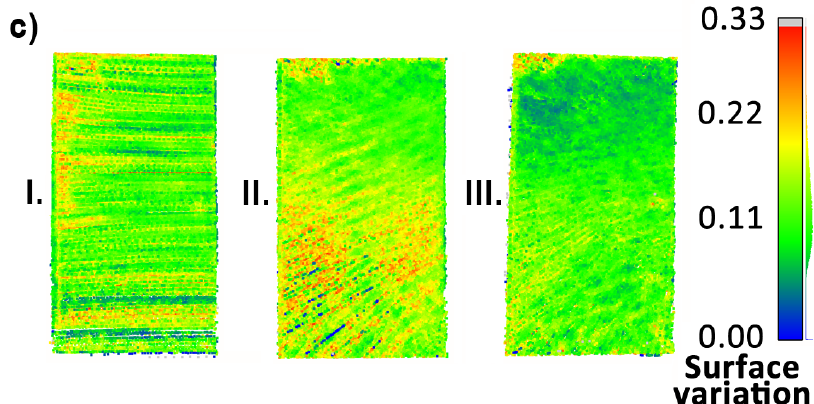
Figure 18. Point cloud surface variation comparison—objects (a) ( left ) and (e) ( right ).